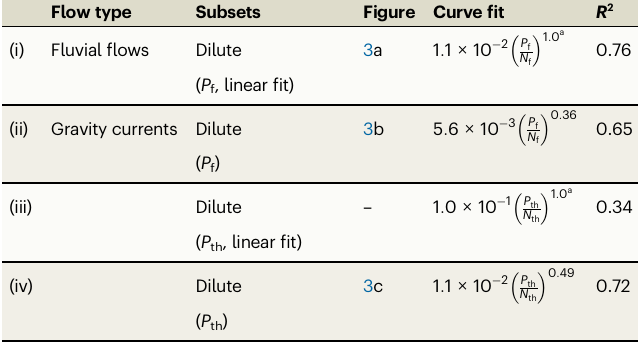
terms of the buoyancy production S = kB th . The dotted-dashed curve has k <1, for which Γ diverges to in fi nity for some values of Φ . Throughout, the Dilute/Transi- tionalregimethresholdandtheideal fl uvial fl owcurveisdepictedbygreysolidand grey dashed lines